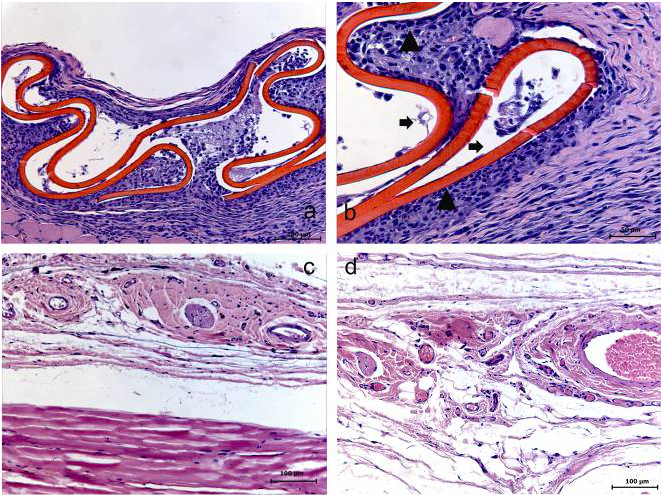
Figure 3. Low molecular weight chitosan (LMWC) group at 7 ( a – b ), 15 ( c ) and 30 ( d ) days. ( a ) The membrane and its surrounding tissue (HE); ( b ) Evidence of the membrane (  ) involved with the presence of a reactional tissue associated with a chronic inflammatory cell infiltrate ( ▲ ) (HE); ( c ) Absence of membrane (HE); ( d ) Tissue already organized